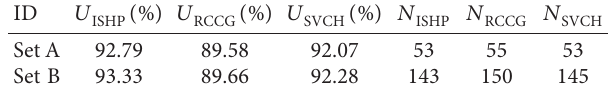
Table 5: Computational results of three